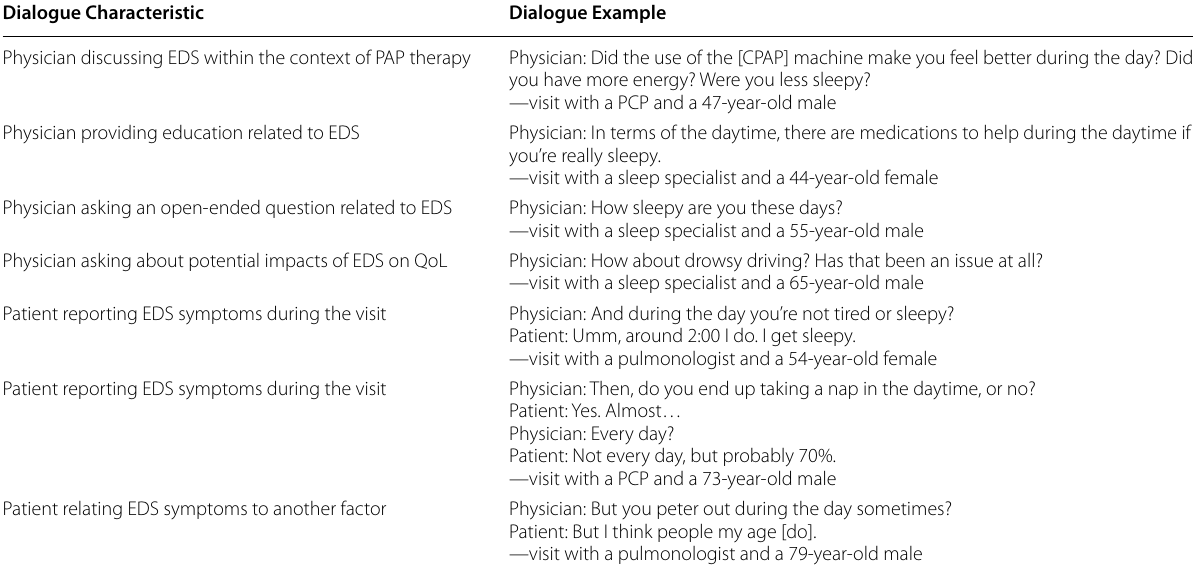
Table 3 Examples of physician and patient visit dialogue